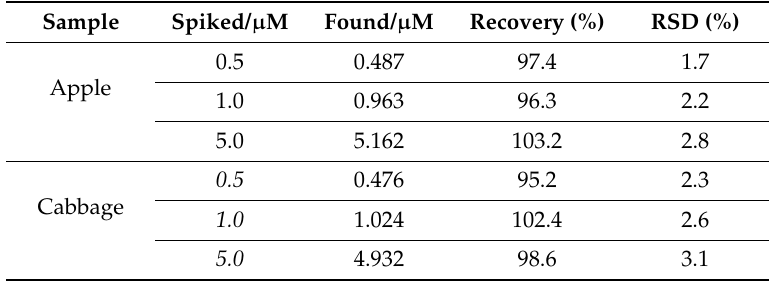
Table 1. The determination results of PO in real samples ( n = 6).